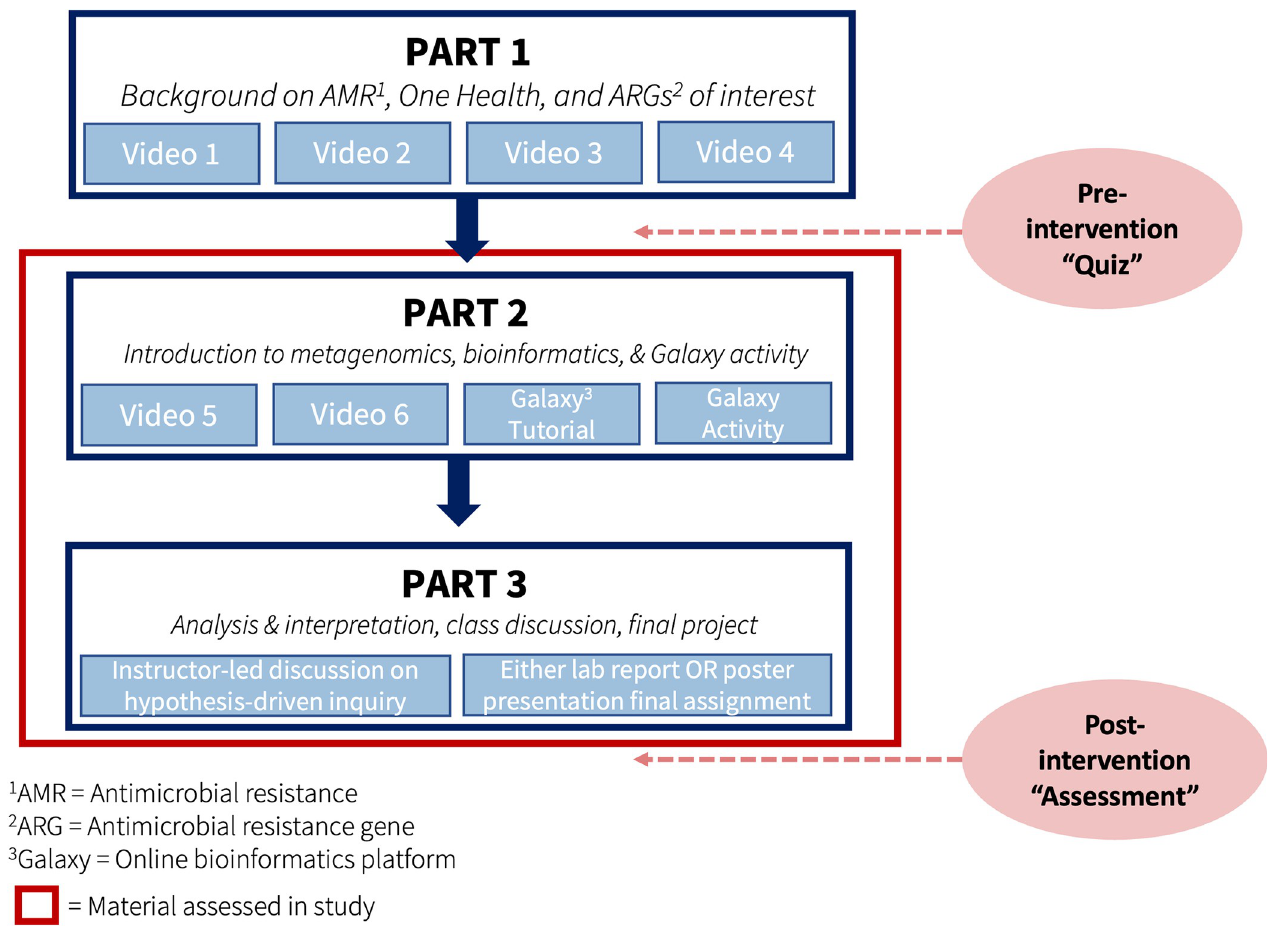
Fig 3. PARE-Seq curriculum and administration timepoints of pre- and post-assessment. PARE-Seq was designed to be administered as a module within an undergraduate or advanced high school biology course.